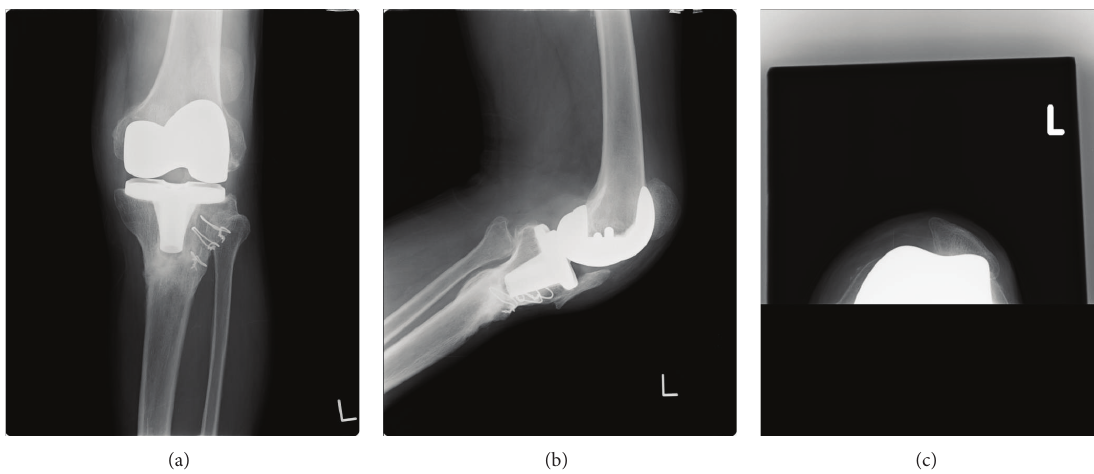
Figure 5: Final follow-up radiographs: anteroposterior view (a), lateral view (b), and skyline view (c) of left knee.